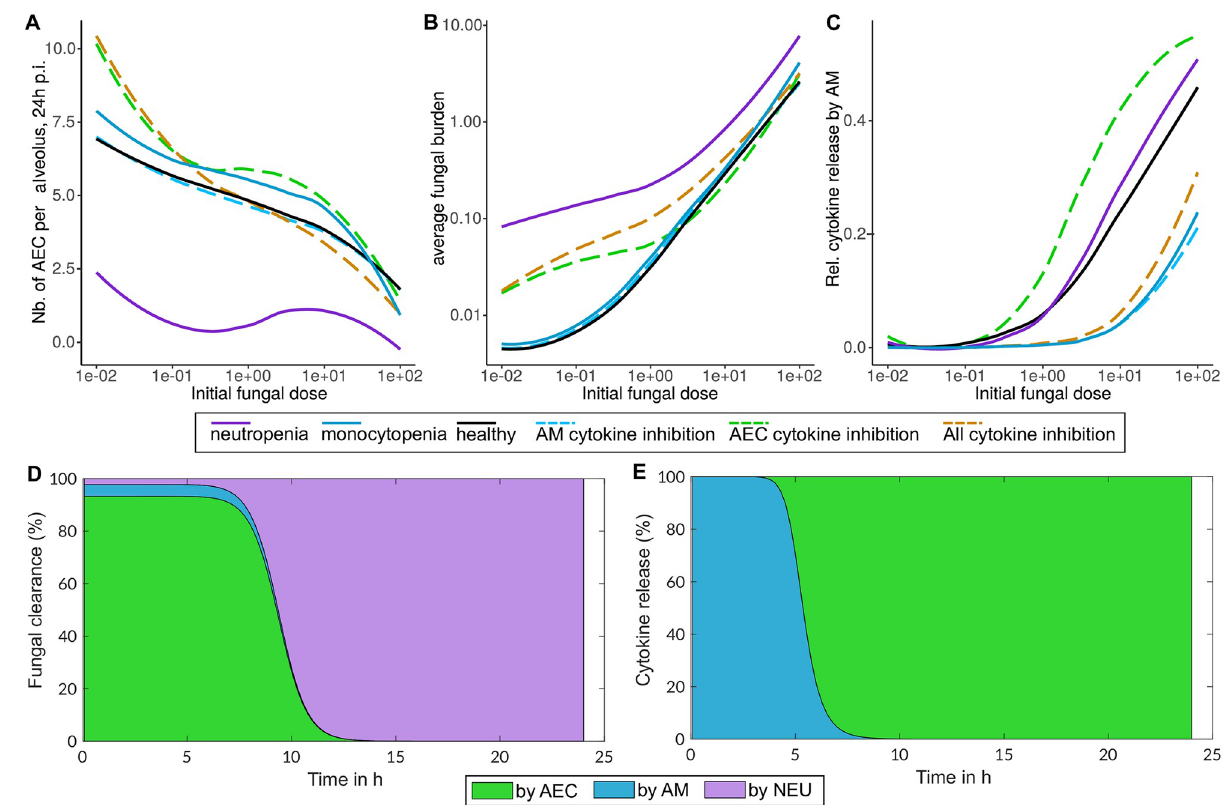
Fig 5. Relative contribution of host cells during infection. A-C Dose-response-curves with varying conidia doses (x-axis) and the remaining number of epithelial cells at the end of simulation in A or the average fungal burden during simulation in B . The relative contribution of alveolar macrophages to cytokine release depending on the initial conidia dose in C . Response curves were determined for the following disturbances: lack of immune cells (1% neutrophils, solid violet; 1% macrophages solid light blue) and cytokine release inhibition (1% of cytokine release by alveolar macrophages (AM, dashed light blue), 1% release by alveolar epithelial cells (AEC, dashed green) or 1% release from both (dashed brown). D, E Role of macrophages (AM), neutrophils (NEU) and epithelial cells (AEC) in fungal clearance D and cytokine release E in the dynamic optimization model over time as percentage of total at each time point. Fungal clearance is calculated as the sum of killing all fungal cell types (conidia and